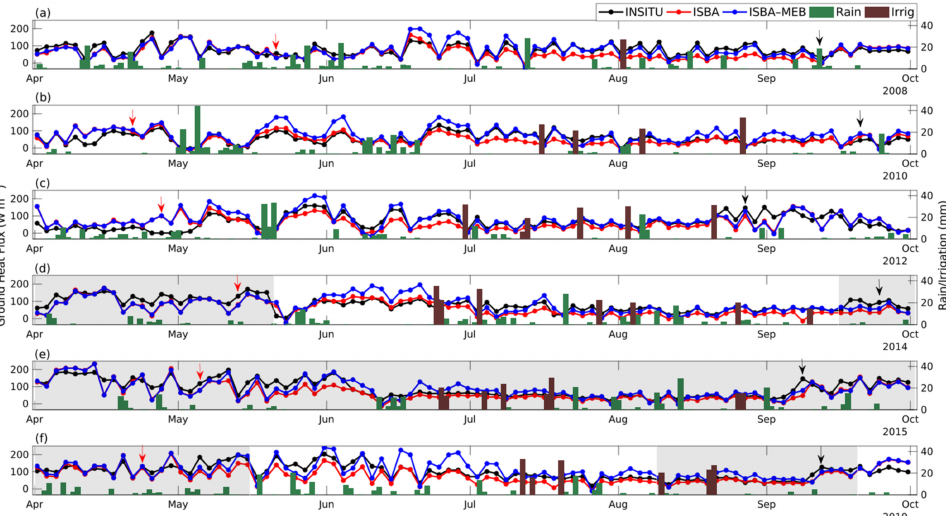
Figure 7. The 2-days average daytime series of the in situ ground heat flux (G) (in black) with those estimated by ISBA (in red) and ISBA-MEB (in blue). Panels ( a – f ) represent the plots for 2008, 2010, 2012, 2014, 2015, and 2019, respectively. The red and black arrows signify the planting and the harvest days, respectively. The grey sectors represent periods when G was estimated from the empirical equations (see